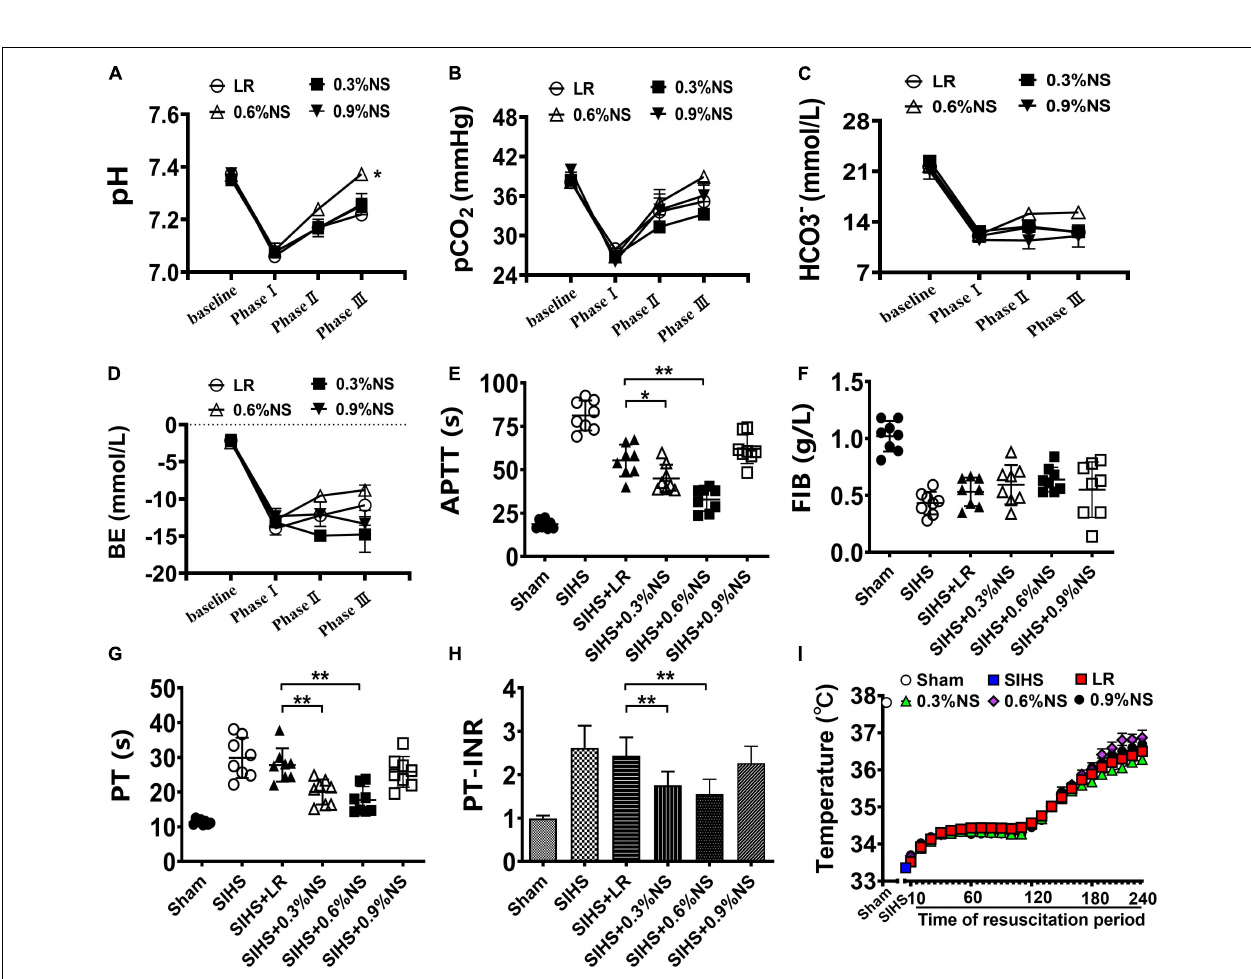
FIGURE 2 | Effects of different osmotic fluids on lethal triad with seawater immersion in hemorrhagic shock rats. (A) : pH value of blood. (B) Partial pressure of carbon dioxide (PCO 2 ). (C) Bicarbonate ion (HCO 3 – ). (D) Residual base (BE). (E) Activated partial thromboplastin time (APTT). (F) Fibrinogen (FIB). (G) Prothrombin time (PT). (H) Prothrombin time-international normalized ratio (PT-INR). (I) Core temperature. LR, lactated Ringer’s solution; NS, normal saline; Sham, Sham-operated group; SIHS, seawater immersion combined with hemorrhagic shock; baseline, before model. Phase I, SIHS for 2 h; Phase II, at the end of resuscitation; Phase III, at the end of rewarming and recovery treatment. Temperature, the core temperature and was recorded every 10 min from the out of seawater immersion until the end of the experiment, for a total of 4 h. * p < 0.05, compared with LR control group; ** p < 0.01, compared with LR control group.